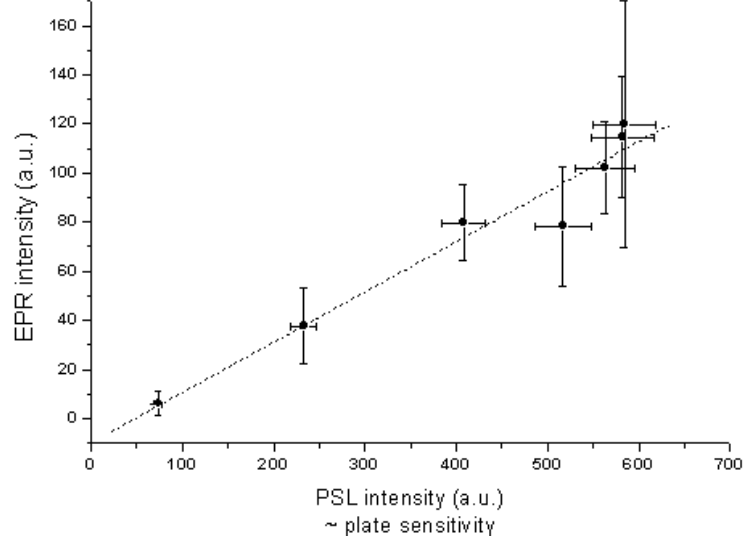
Figure 27. Intensity of the characteristic EPR signal vs . PSL activity for samples of the same NIP treated in different ways [98] (reproduced with permission from Frank Loncke).